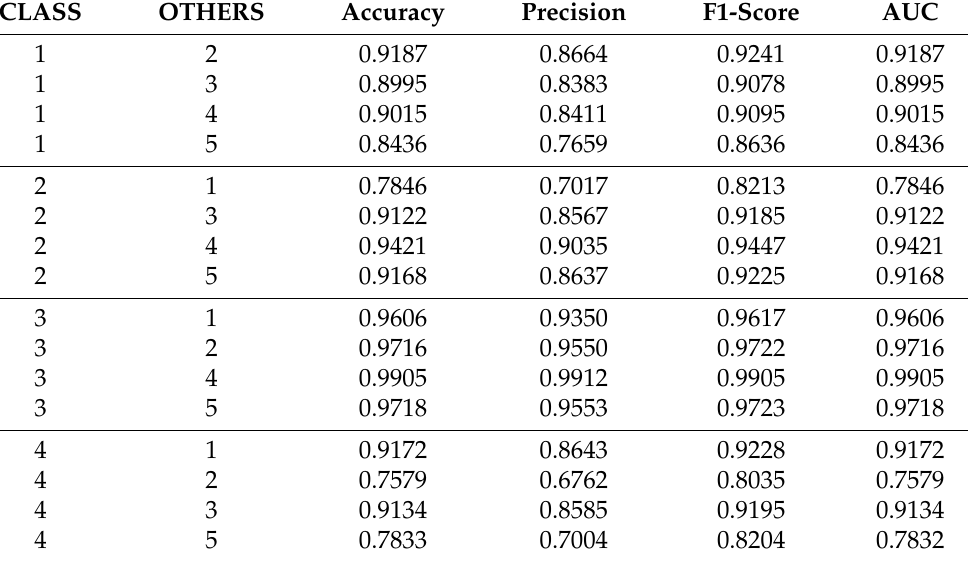
Table 3. DBN-driven EE identification